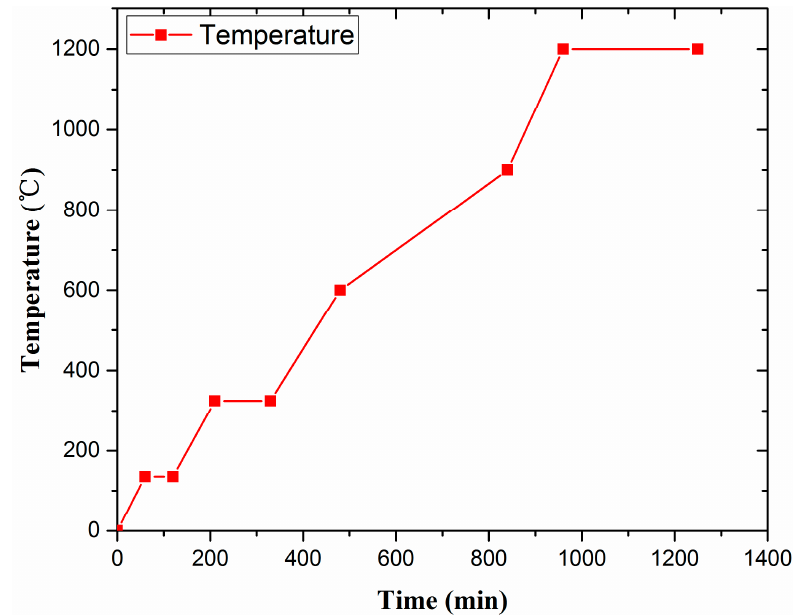
Figure 6. Sintering curve of supports.